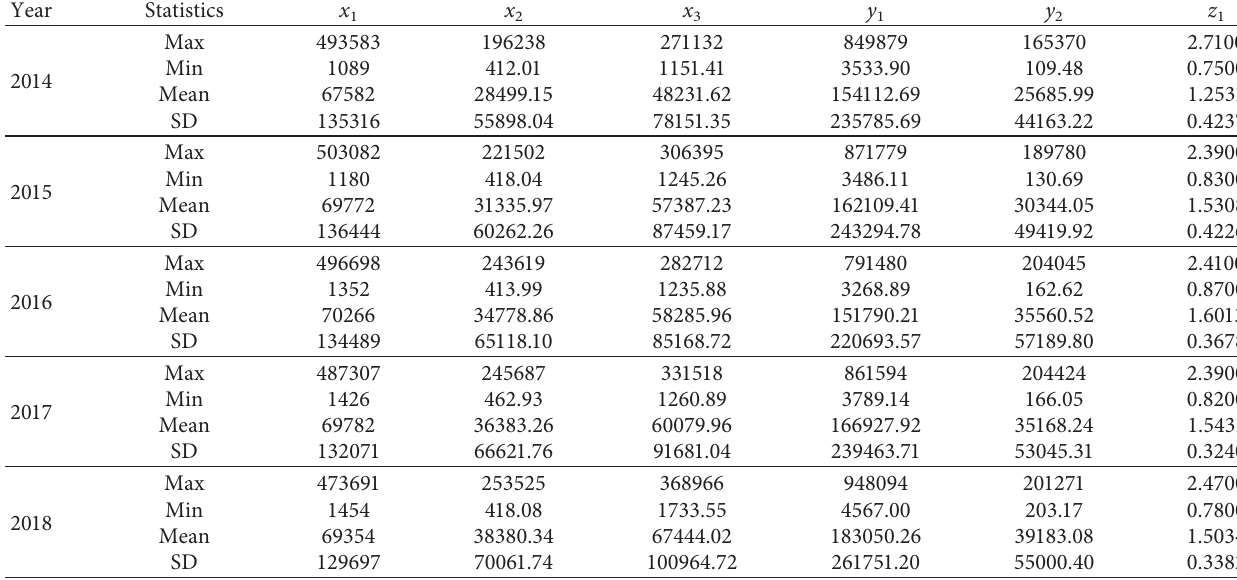
Table 3: Descriptive statistics for input-output measures.